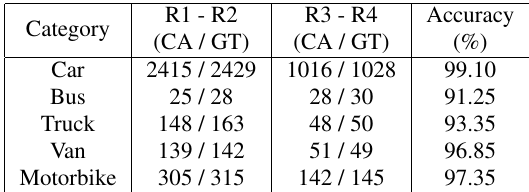
Table 4. The framework results of scenario